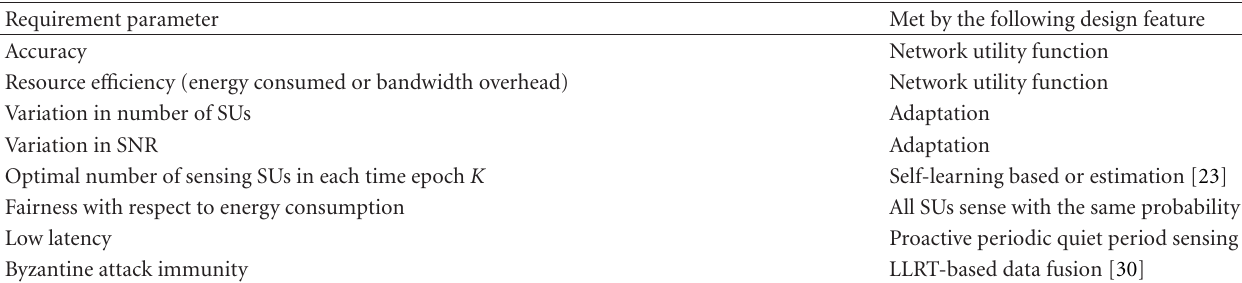
Table 3: Requirements of emergency